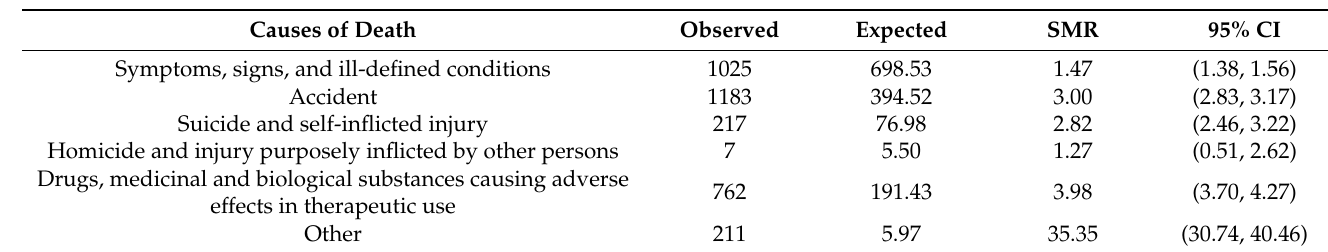
Figure 2. All-cause standardized mortality ratio (SMR) of peritoneal dialysis (PD) patients stratified by gender.